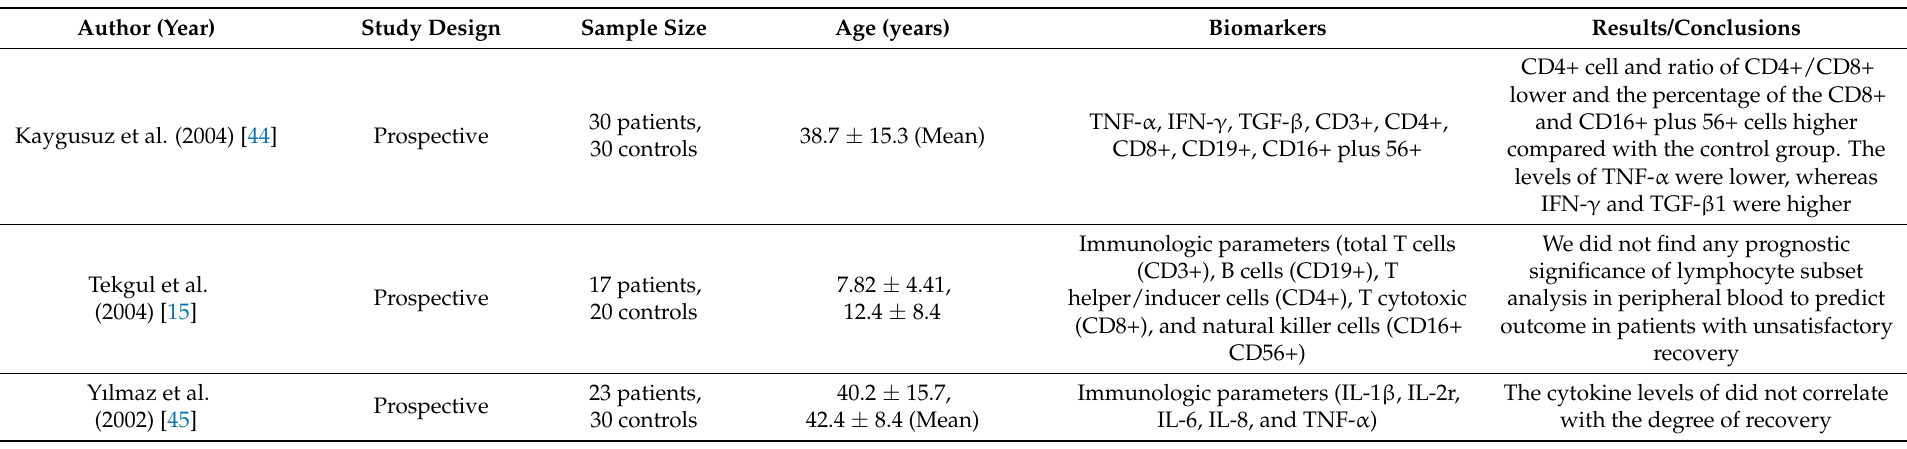
Table 4. Summary of prognostic biomarkers for acute peripheral facial palsy (Immunologic parameter).